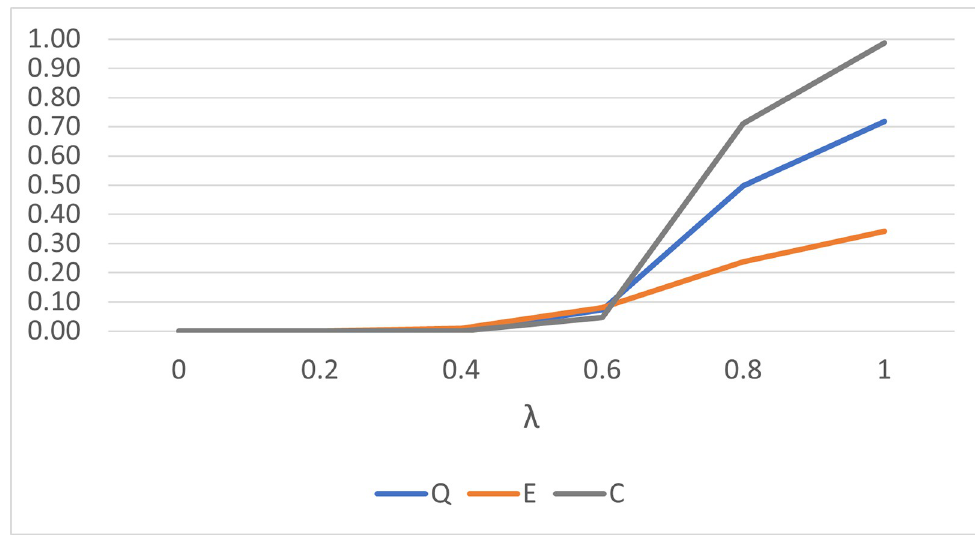
Fig 1. The performance of the Q k , E k and C k statistics for n = 10 and κ = 3 for a single